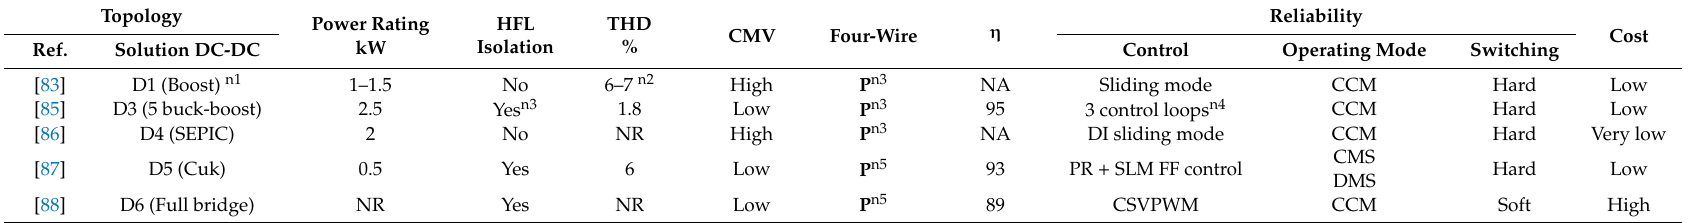
Table 1. Performance comparison for selected topologies of di ff erential